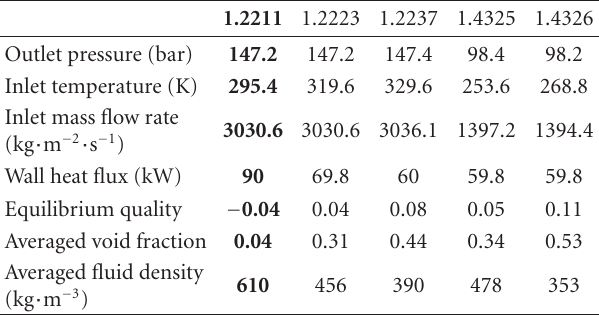
Table 1: Characteristics of the five selected test-cases. In bold font, the run whose condition are the closest to PWR normal conditions.